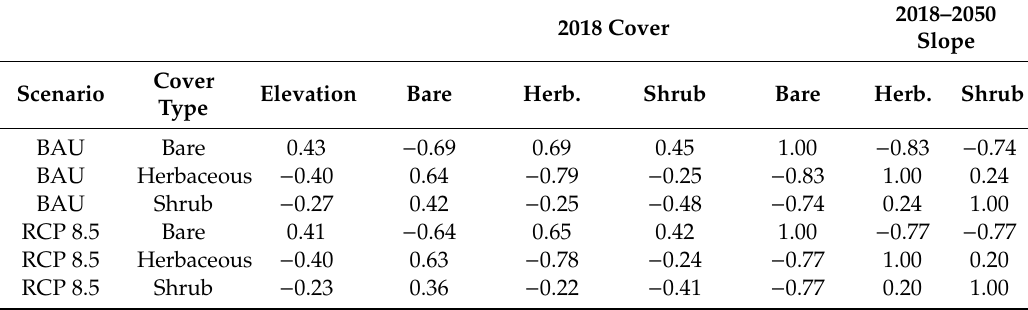
Table 4. Correlation ( r ) between fractional cover slope from 2018 to 2050 by scenario and elevation, 2018 cover, and 2018 to 2050 slope of other cover types. All correlations are significant ( p < 0.05).